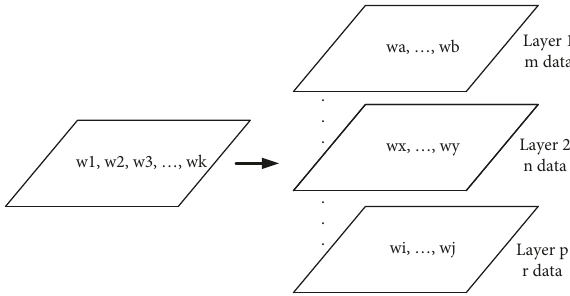
Figure 3: Schematic diagram of weighted fusion for